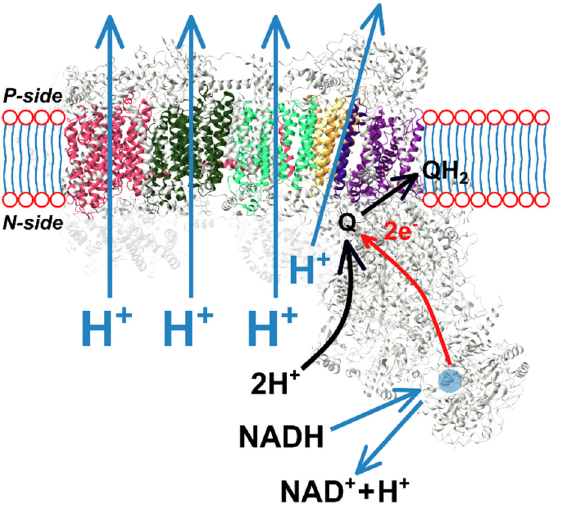
Figure 1. Schematics of proton-pumping Complex I. The protein structure is taken from [10].